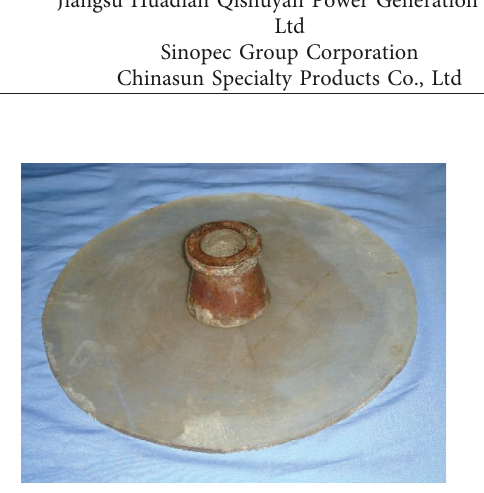
Figure 1: Fluidity